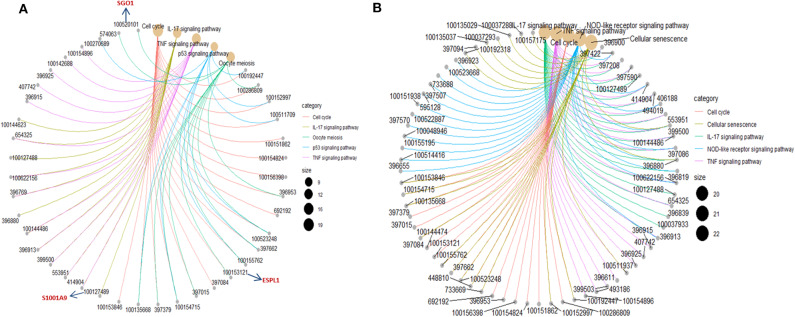
Hub pathways and associated genes in (A) ETEC F4ab and (B) ETEC F4ac infections.